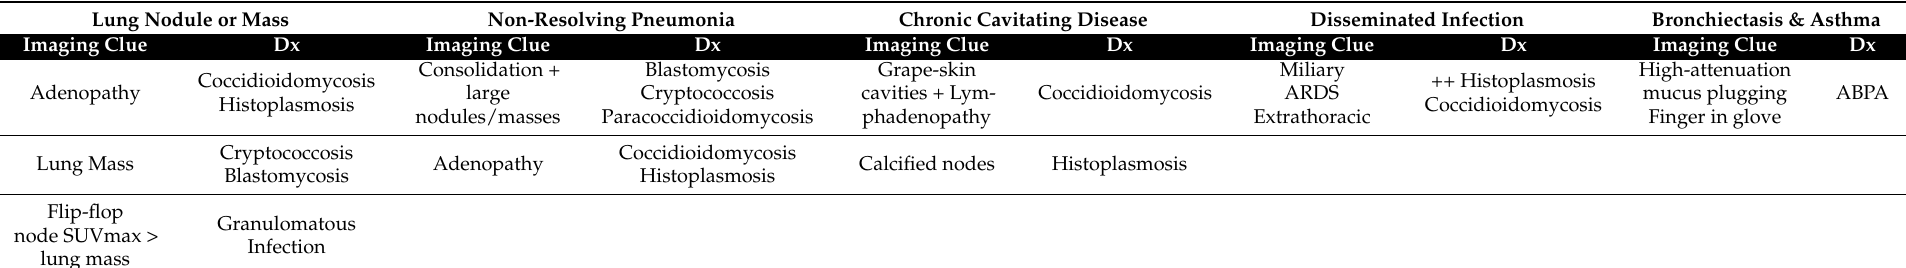
Table 1. Chest imaging findings of systemic endemic